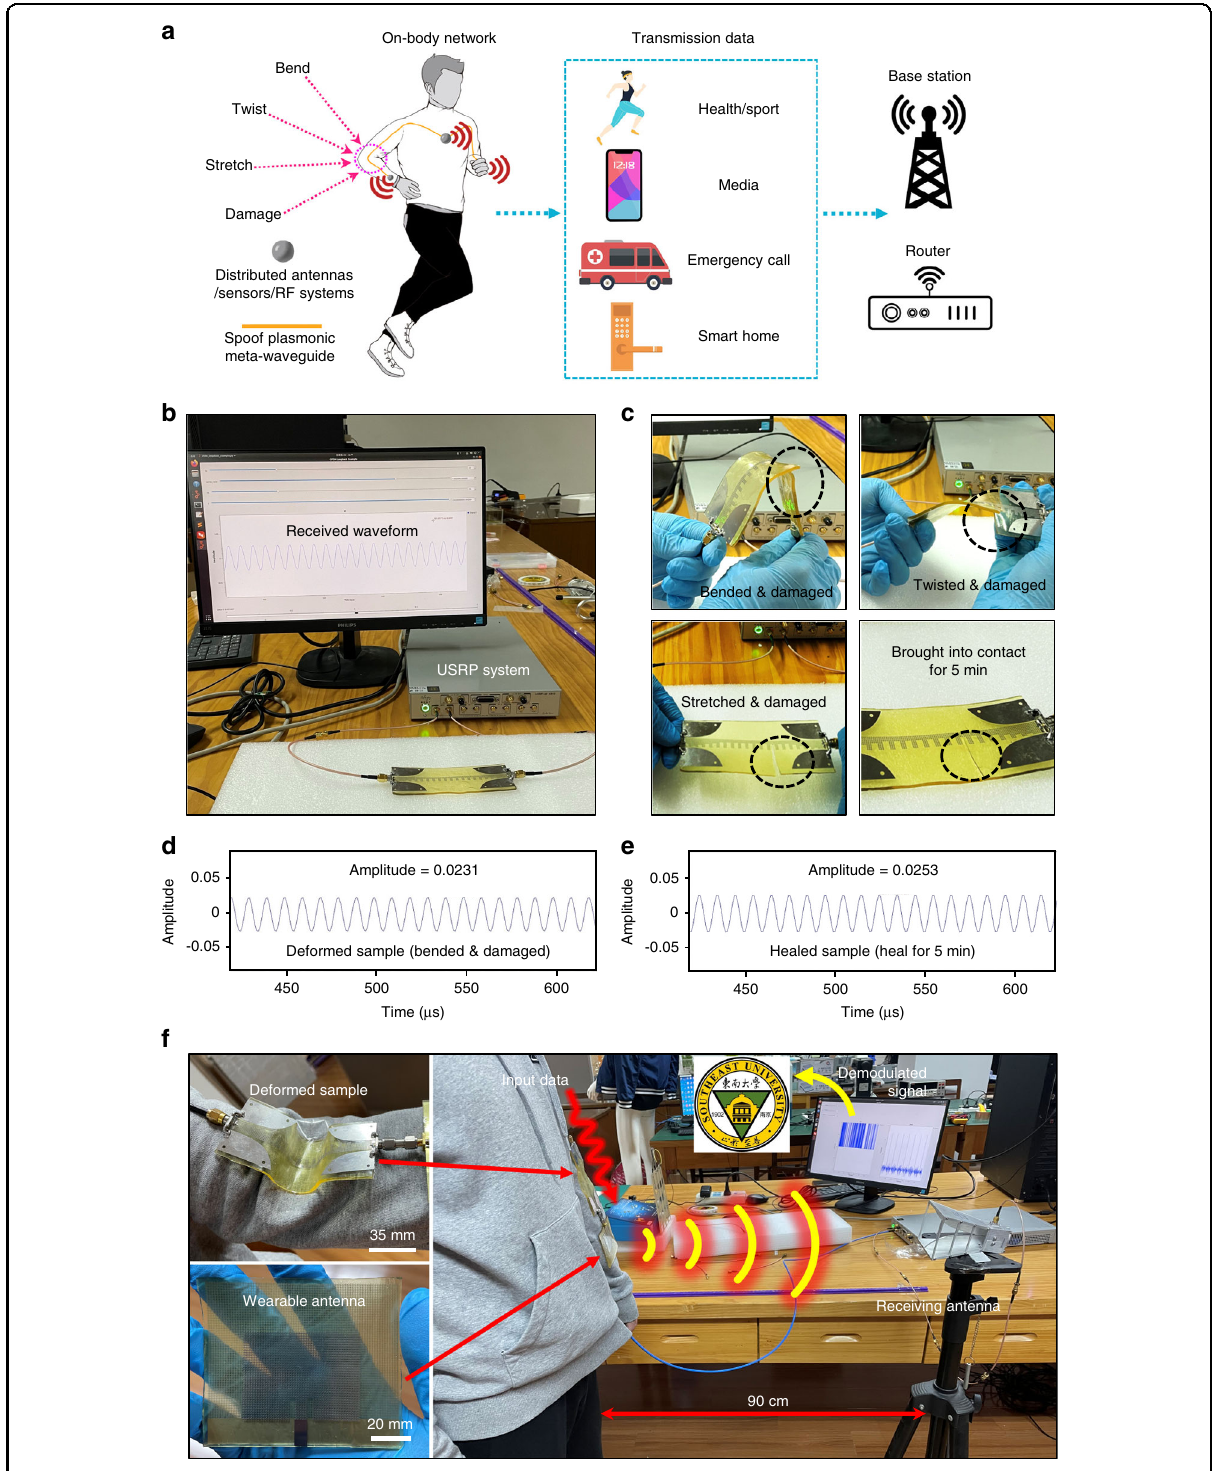
Fig. 6 Communication performance of the spoof plasmonic meta-waveguide. a Conceptual illustration of the body area network based on the spoof plasmonic meta-waveguide. b Measurement setup of the waveform transmission experiment. c Photos of the damaged and deformed meta- waveguide. d Received waveform of the bend and damaged sample. e Received waveform of the healed sample. f On-body wireless communication experiment of the spoof plasmonic meta-waveguide with the help of the USRP system and wearable